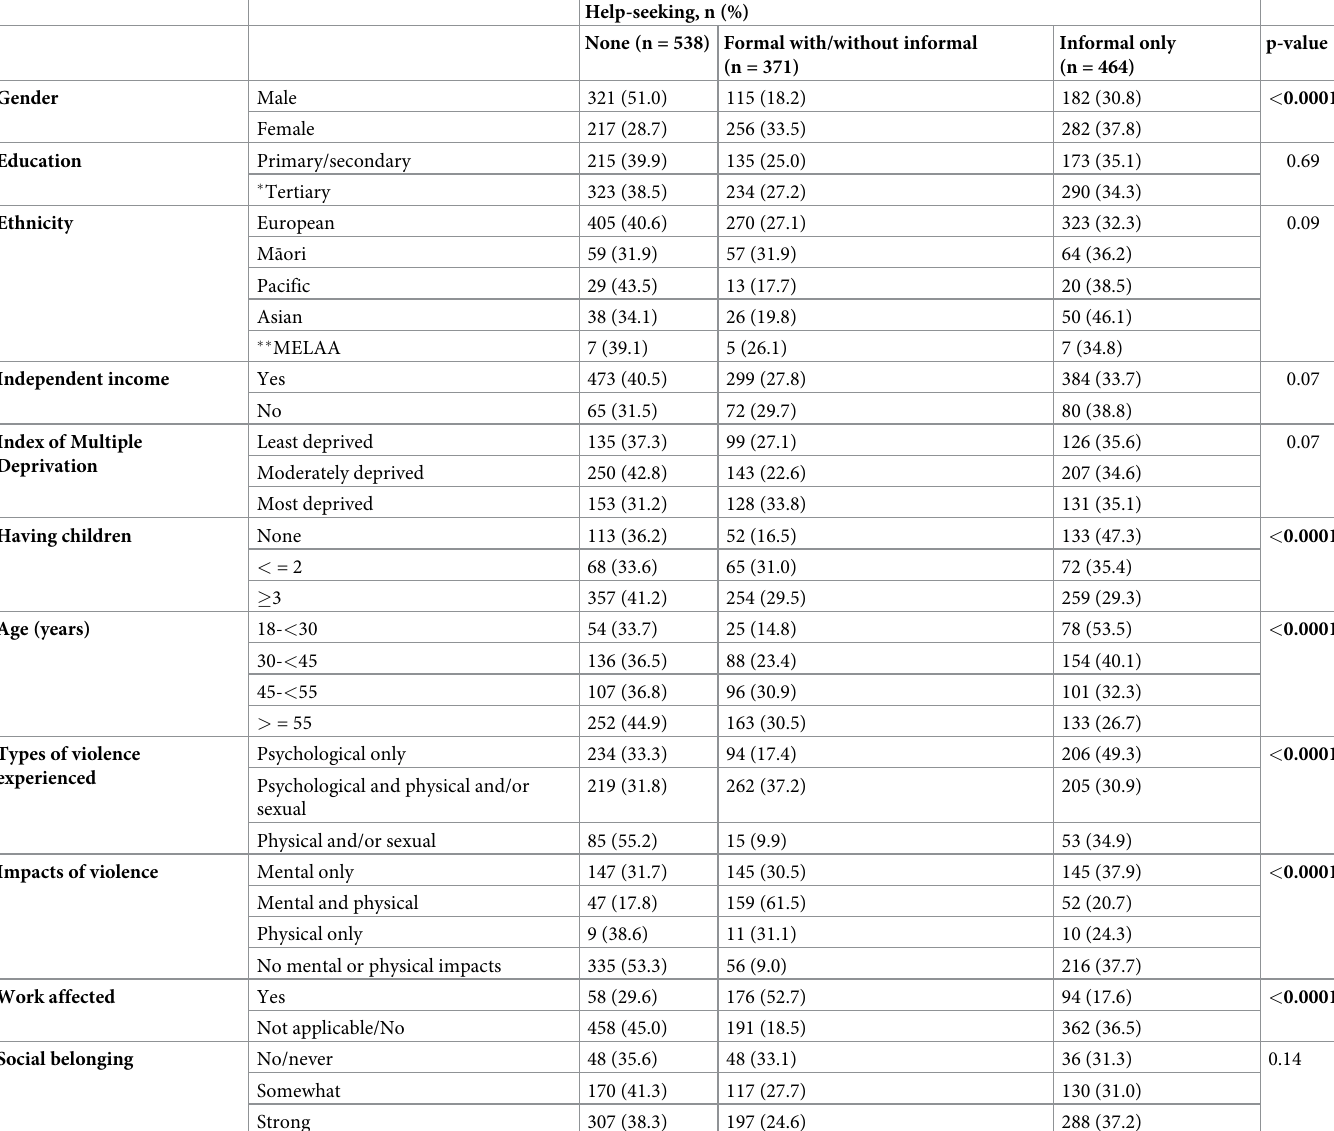
Table 1. Help-seeking by those who experienced psychological and/or physical and/or sexual IPV from the 2019 New Zealand Family Violence Study (n = 1,373).